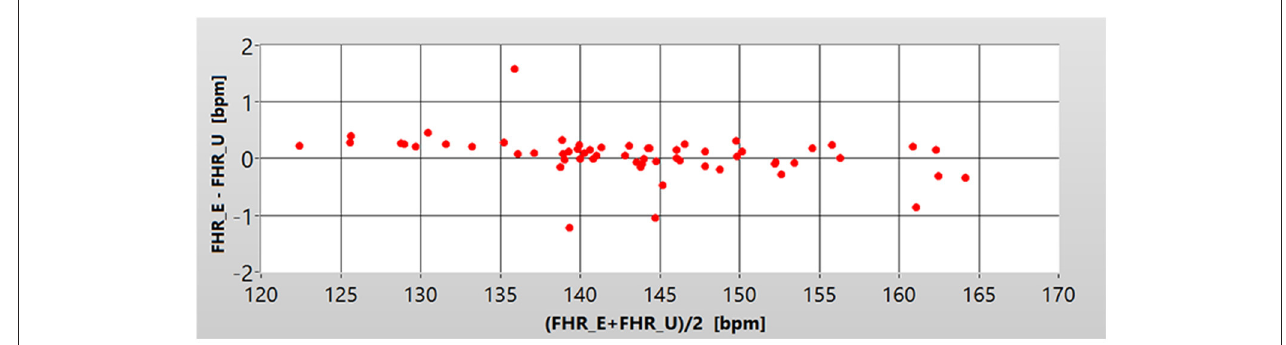
FIGURE 2 | Bland Altman plot showing the dependence of the mean value of the differences MD (Y axis) between corresponding instantaneous values of FHR_U and FHR_E, in relation to the average fetal heart rate in the recording (X axis), for each of the 60 pairs of signals. The values are expressed in beats per minute—bpm.